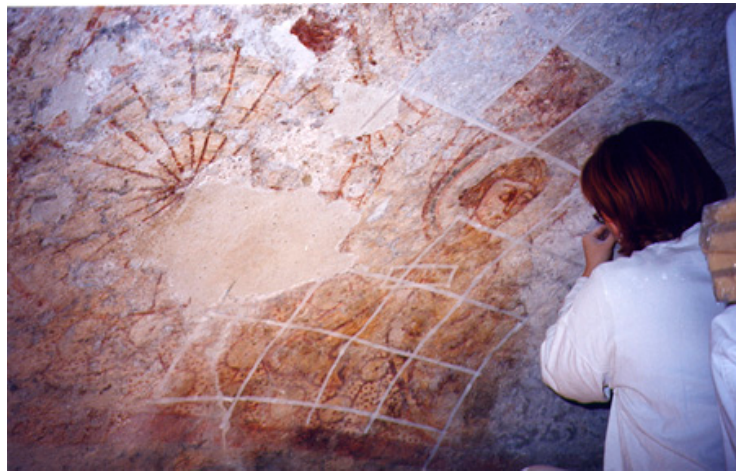
Figure 30. Sant Miquel de Terrassa. Restoration of the paintings undertaken in the years 2001 and 2002. © ARCOR.